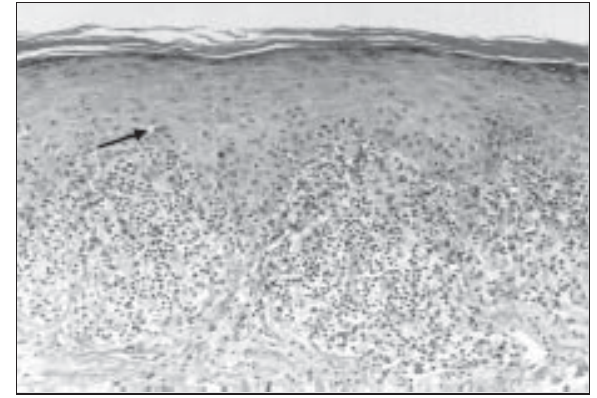
Figura 2 – Líquen plano cutâneo. Hiperceratose compacta, hipergranulose leve, acantose leve, corpos de Civatte (seta), vacuolização da camada basal, infiltrado inflamatório superficial (HE, aumento original 100x)